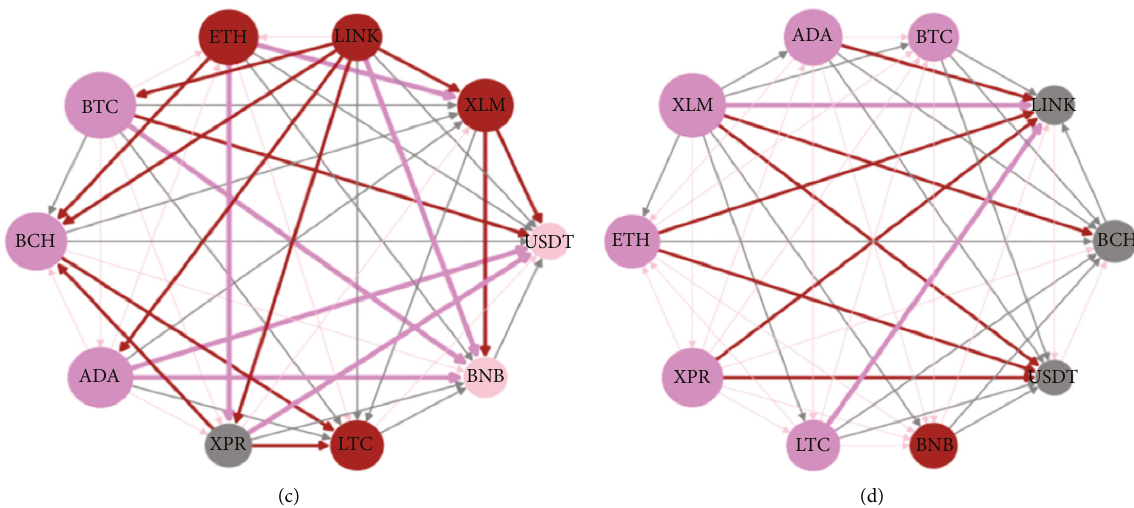
Figure 7: Net spillover network analysis of cryptocurrency market before and after COVID-19. (a) Net spillover network pre-COVID-19 (volatility spillovers). (b) Net spillover network post-COVID-19 (volatility spillovers). (c) Net spillover network pre-COVID-19 (return spillovers). (d) Net spillover network post-COVID-19 (return spillovers). Note: this figure shows the net directional connectedness among the ten cryptocurrencies’ volatility and returns. The size of each node indicates the overall magnitude of spillover transmission for each cryptocurrency, which is measured by net connectedness in Table 3. Node’s size indicates the spillover intensity for each cryptocurrency, and edge’s direction represents the pairwise spillover direction between different